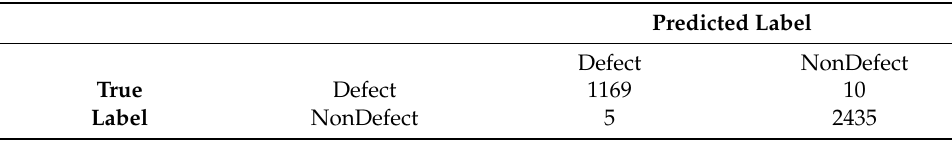
Table 5. Confusion matrix of the test set for defect